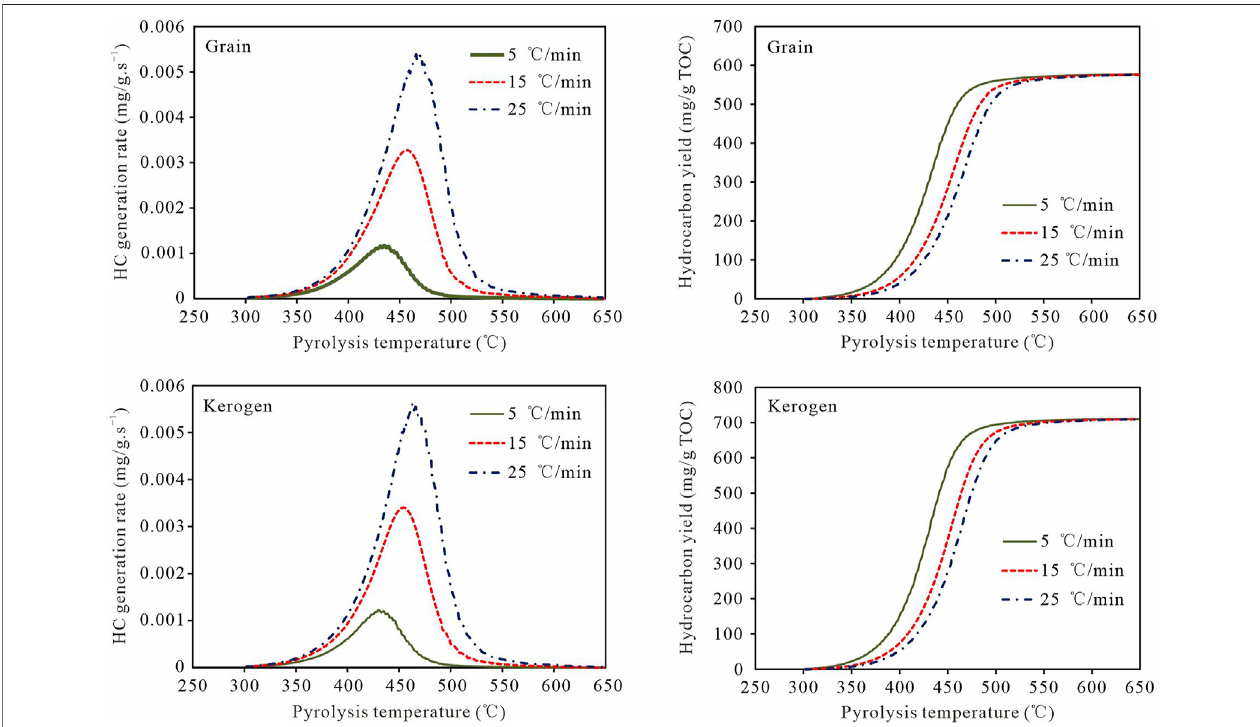
FIGURE 4 | Hydrocarbon (HC)-generating rates and hydrocarbon yield of grain and kerogen from MM oil shale as a function of pyrolysis temperature at different heating rates.